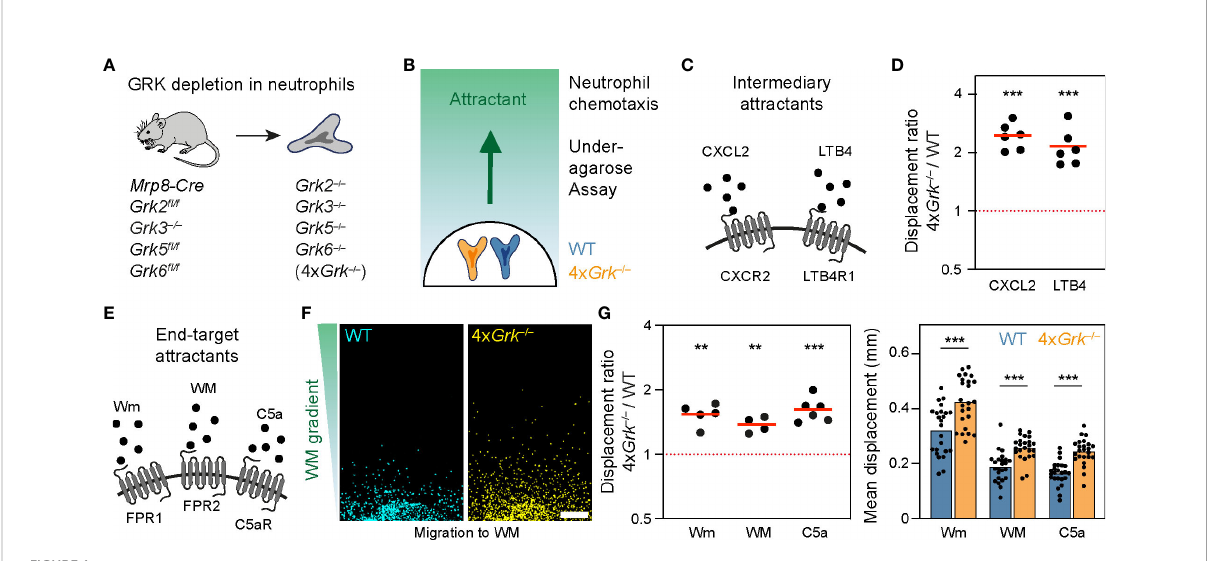
FIGURE 1 Neutrophils lacking all four GRKs show a general increase in chemotactic responses (A) Scheme of the mouse model used for the generation and isolation of neutrophils with complete lack of all four GRK isoforms (see (7) for gene knockout ef fi ciency). (B) Scheme of the under-agarose chemotaxis assay, in which differentially stained WT and 4x Grk − / − neutrophils migrate side by side towards a chemoattractant gradient. (C) Scheme of intermediary attractants and their corresponding GPCRs CXCR2 and LTB4R1 expressed by neutrophils. (D) Migration to 1 µM CXCL2 and 1 µM LTB4 was measured after 4 h and is displayed as displacement ratios of 4x Grk – / – versus WT cells. n = 6 biological replicates performed as independent experiments with N = 3-8 technical replicates each. Bars display the mean. *** P < 0.001, ** P < 0.01, one sample t test. (E) Scheme of end-target attractant stimuli and their corresponding GPCRs FPR1, FPR2 and C5aR expressed by neutrophils. (F) Migration to 50 µM WM peptide, endpoint images after 4 h. Scale bar: 200 µm. (G) Migration to 1 µM Wm, 50 µM WM and 1 µM C5a was measured after 4 h and is displayed as displacement ratios of 4x Grk – / – versus WT (left) and mean displacement (right). n = 4-6 biological replicates performed as independent experiments with N = 3-8 technical replicates each. Bars display the mean. *** P < 0.001, ** P < 0.01, one sample t test (left), t test